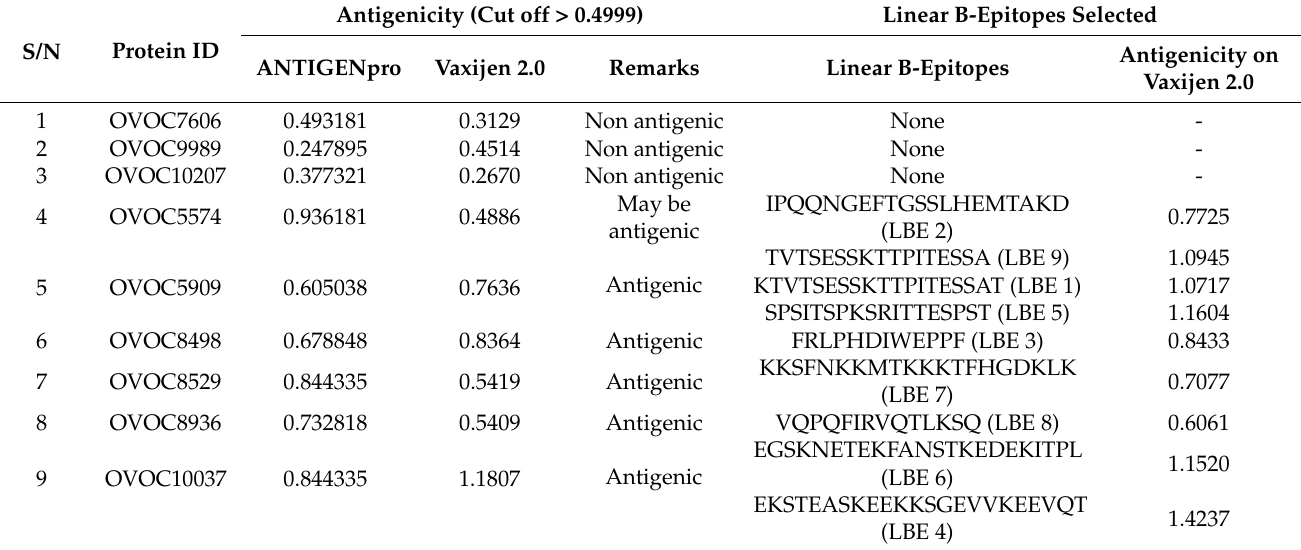
Table 1. Antigenicity of low conserved proteins in related nematodes and selected linear B-epitopes.